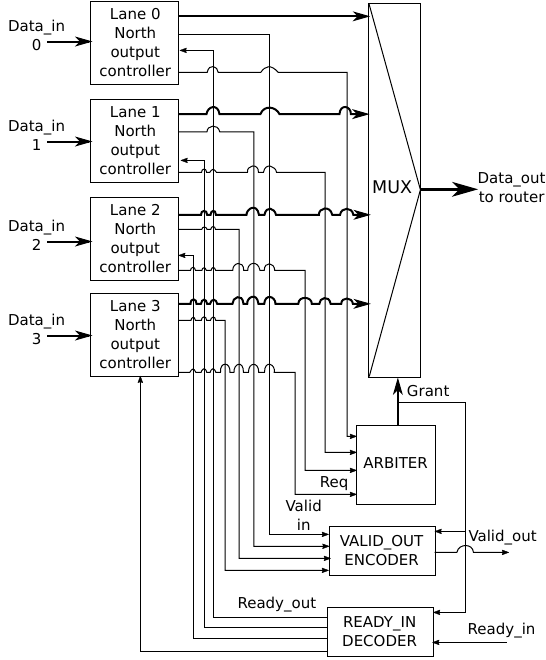
Figure 10. R-NoC output port block